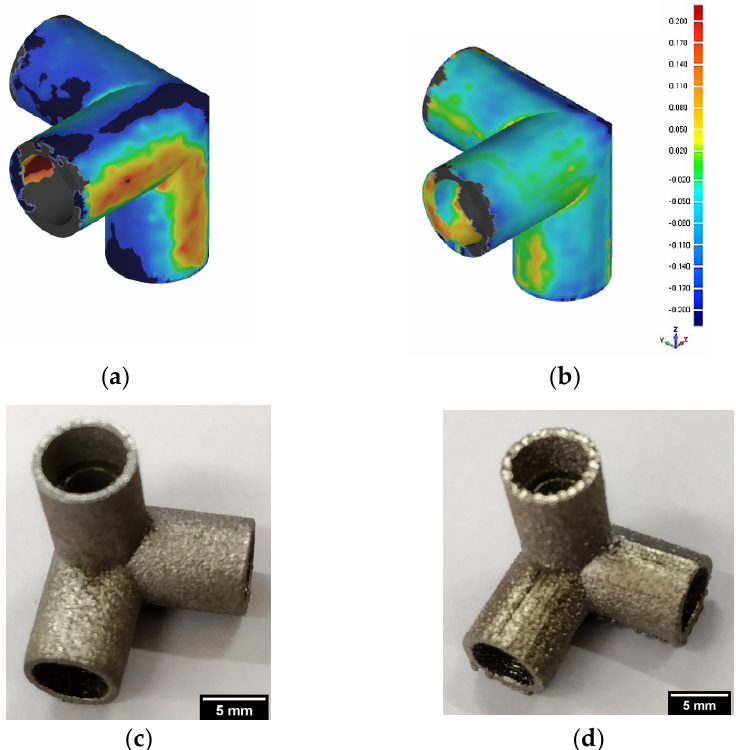
Figure 2. Shapes and dimensions of the connectors: Isometric view of the connector pieces: ( a ) SLM and ( b ) EBM. Scale at the right. Actual pieces: ( c ) SLM and ( d ) EBM connectors.